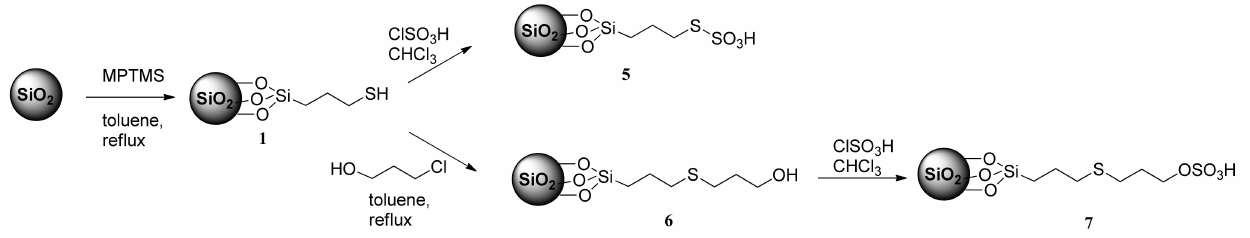
Figure 3. Synthetic approaches for catalysts in which the SO 3 H group is directly linked to heteroatoms based on Nikman’s group studies [17,18].